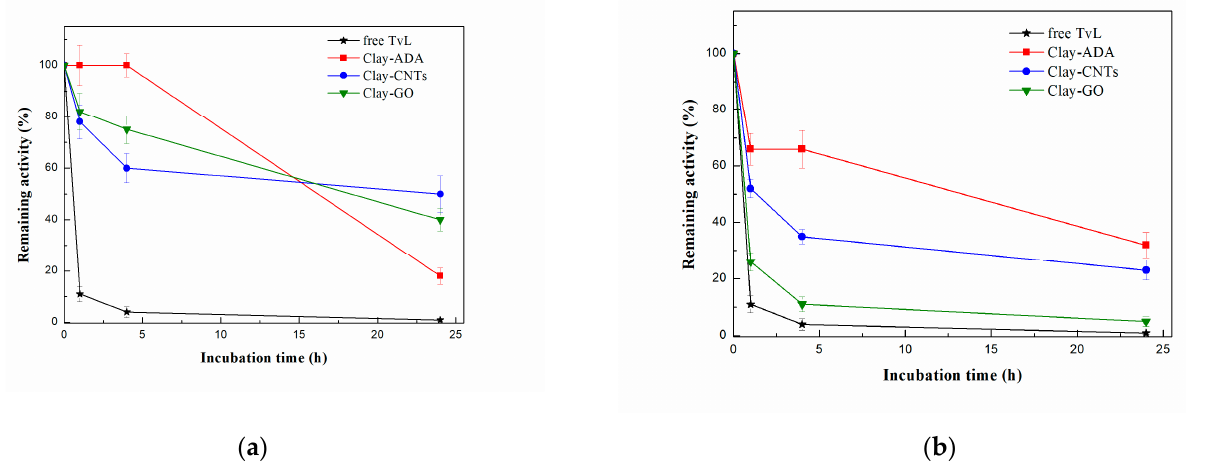
Figure 1. Stability of ( a ) non-covalently and ( b ) covalently immobilized TvL on hybrid nanomaterials, after incubation in acetate buffer, at 60 °C. As 100% is indicated the enzyme activity at t = 0.